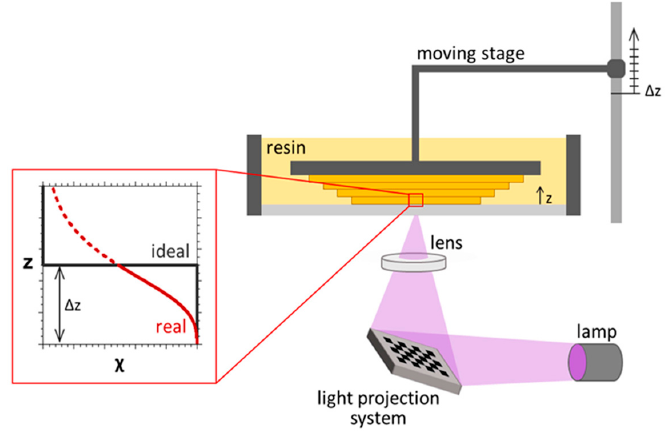
Figure 4. Schematic showing of a bottom-up vat photopolymerization 3D printer. Each printed layer, with a thickness of Δ z, was characterized by a non-constant monomer-to-polymer conversion χ , which showing a sigmoidal profile (red), and varies from the ideal square profile (black). Reprinted with permission from Ref. [53]. Copyright 2016 by the authors and licensee MDPI, Basel, Switzerland.